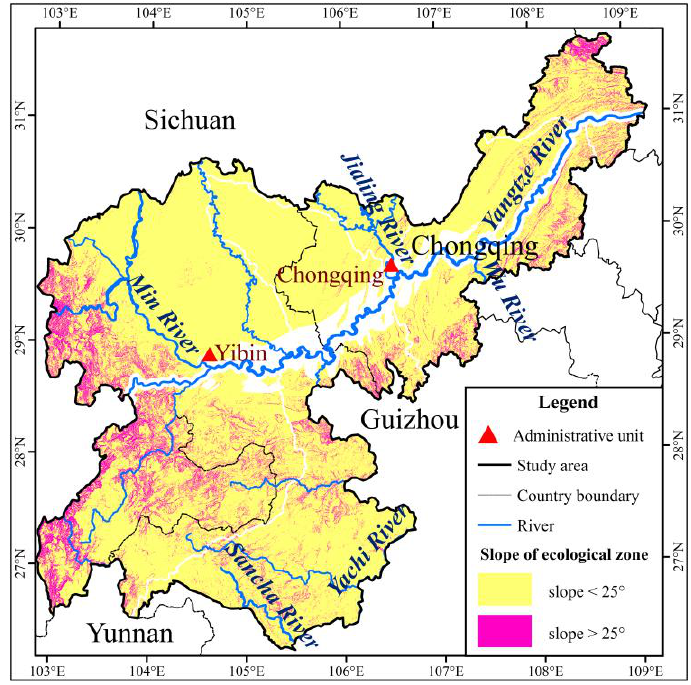
Figure 8. Overall pattern of ecological protecting-barrier construction planning.